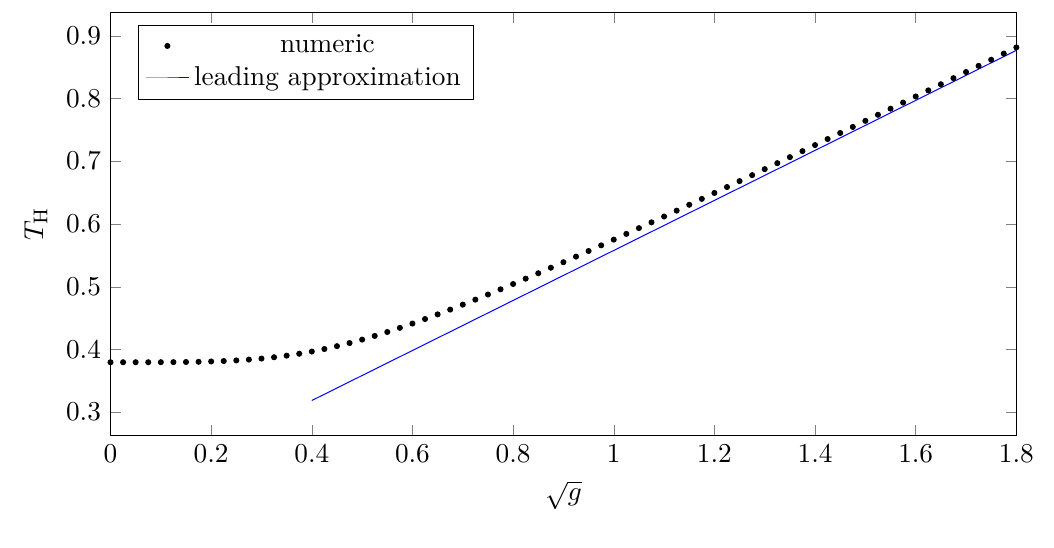
Figure 5. Numeric results and leading strong coupling approximation. for the Hagedorn temperature √ as a function of g